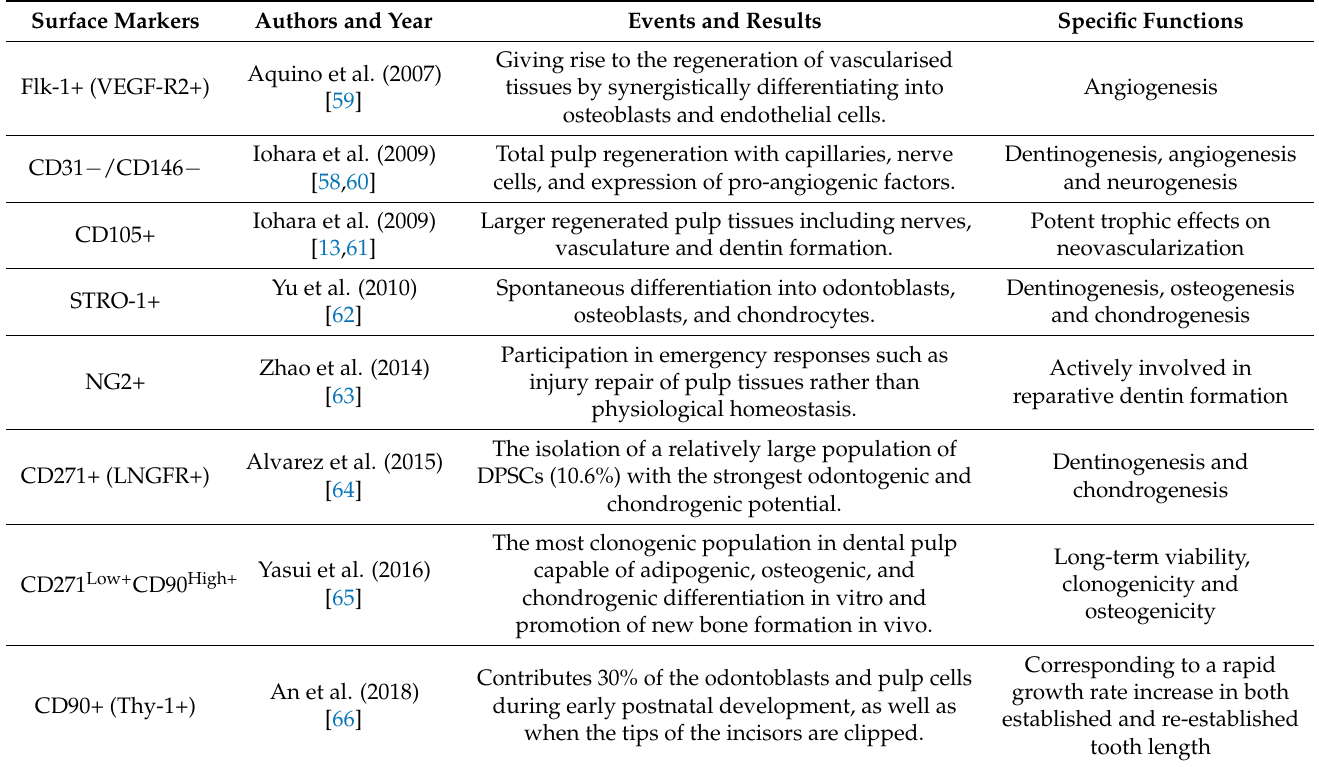
Table 5. Specific surface markers of DPSCs and their